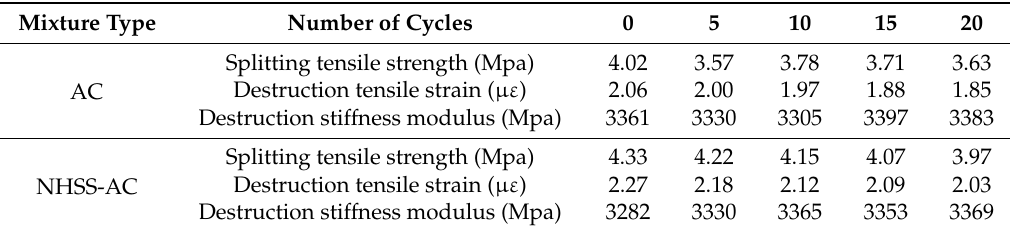
Table 5. Results of − 10 ◦ C splitting Table 4. Results of − 10 °C splitting test.